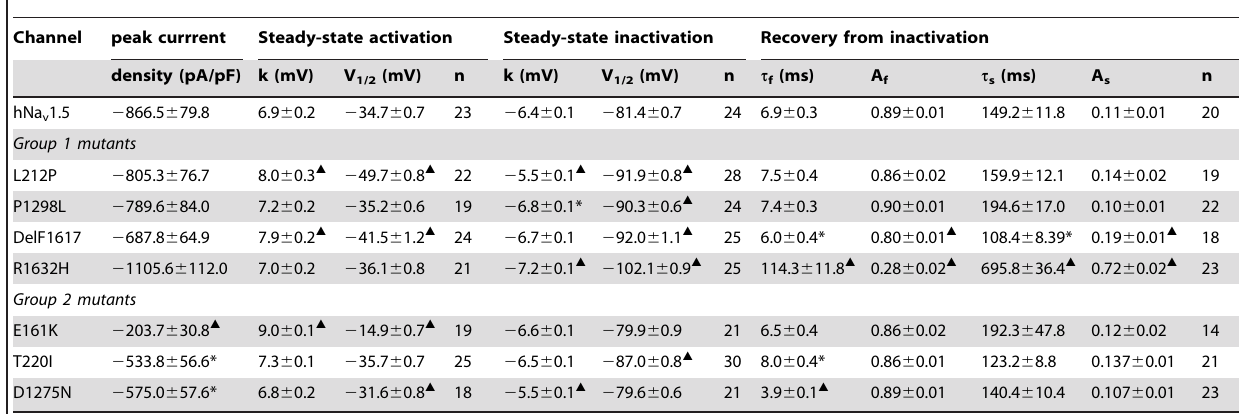
Table 1. Electrophysiological properties of wild-type and mutant hNa v 1.5 channels in HEK293 cells.